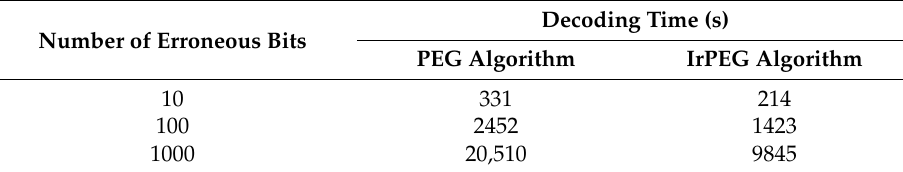
Table 2. Comparison of the decoding time of the E b / N 0 of Code2 at 3